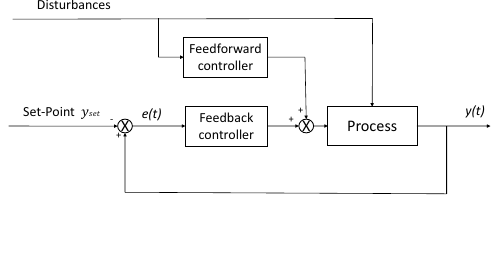
Figure 1: Feedback-Feedforward Control